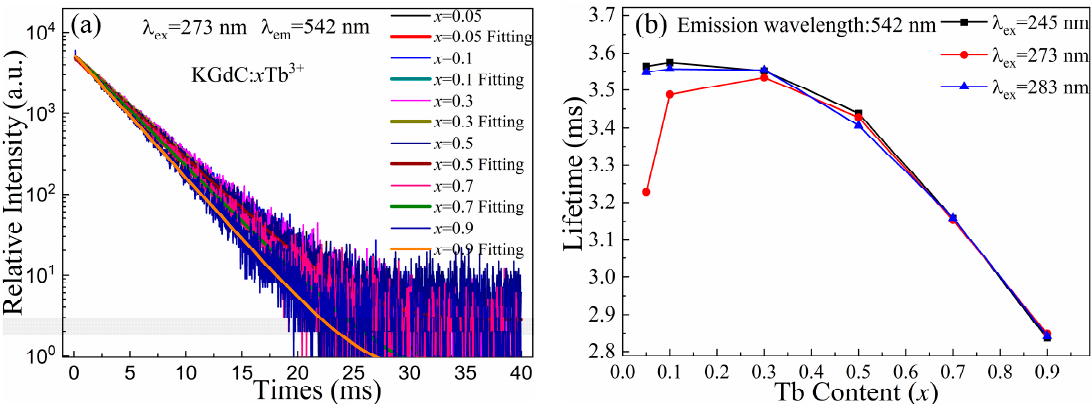
Figure 7. Decay properties of KGdC: x Tb 3+ ( a )decay curves; ( b ) Lifetimes of Tb 3+ 5 D 4 level.